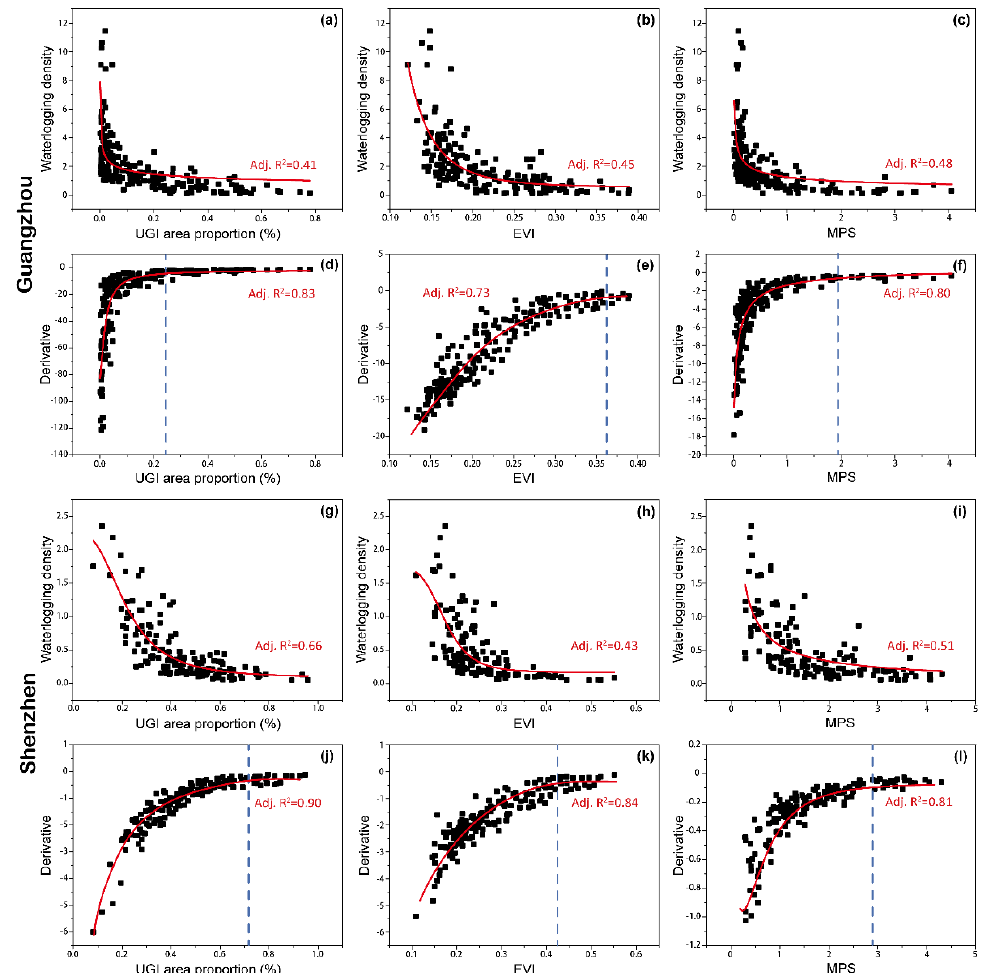
Figure 11. The relationship between UGI variables and waterlogging for ( a )–( f ) Guangzhou and ( g )–( l ) Shenzhen. The red line indicates the nonlinear fitting curve and the derivative curve, and the blue dashed line represents the threshold value.